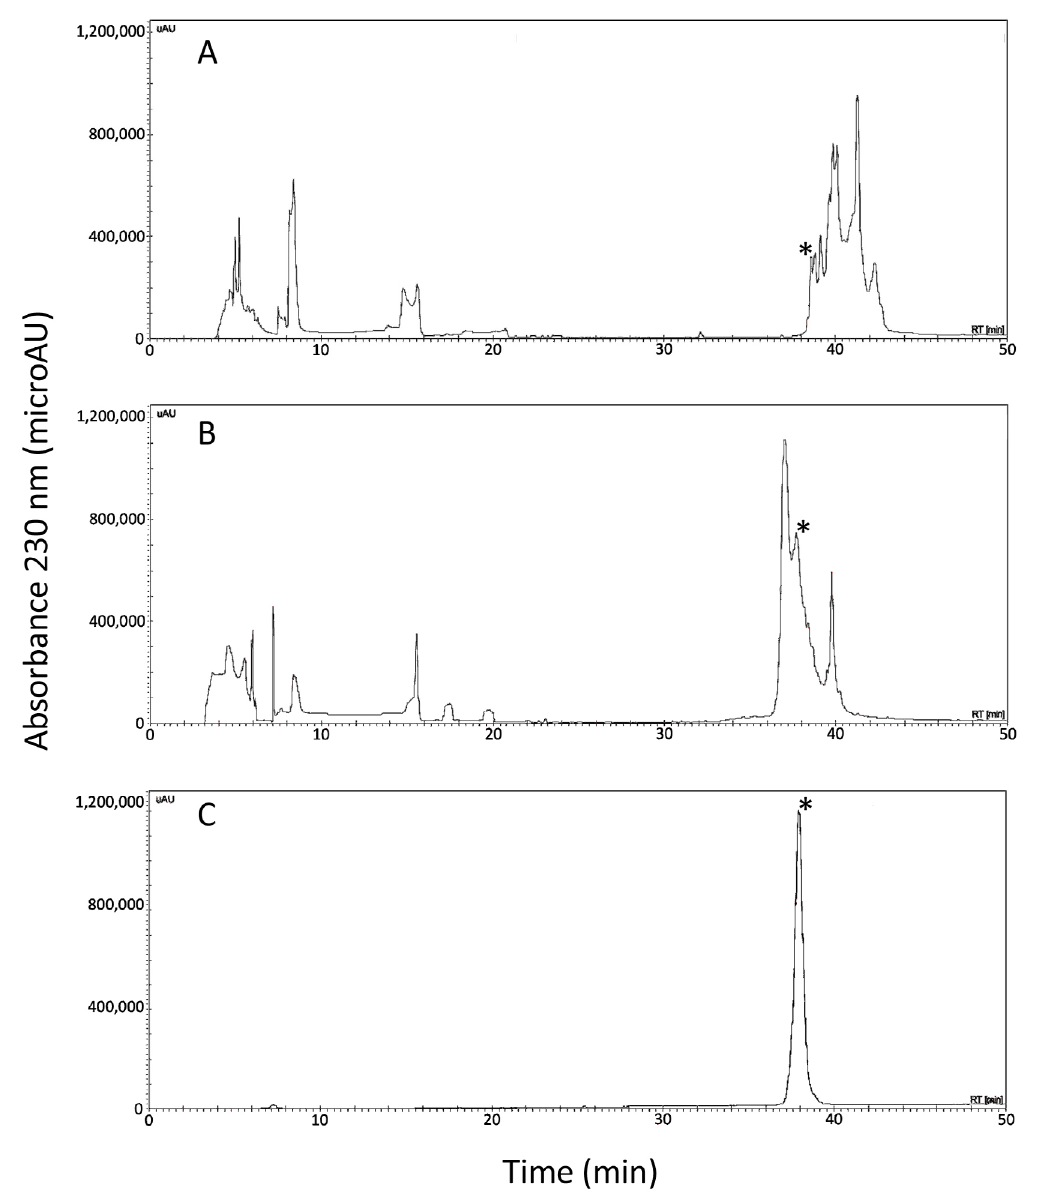
Figure 2. Chromatographic separation before and after protein in vitro folding of HisrSccTx (A) by affinity chromatography before refolding, (B) after purification by refolding and (C) after re-purification. (A) The recombinant protein HisrSccTx was purified by affinity chromatography elution by applying RP-HPLC using an analytical C reversed-phase column (Vydac 214 TP 4.6 x 250 mm, Hesperia, CA, USA) with a linear gradient using solvent A (0.1% 18 trifluoroacetic acid, TFA, in water) and solvent B (0.1% TFA in acetonitrile). The linear gradient was from 0 to 60 % of solvent B over 60 min at 1 mL/min flow rate, with UV detection at 230 nm. (B) The purification of HisrSccTx after the refolding step used similar RP-HPLC conditions as in (A). (C) The re-purification step used similar RP-HPLC conditions as in A and B). The asterisk shows the fraction which presented lethal activity.